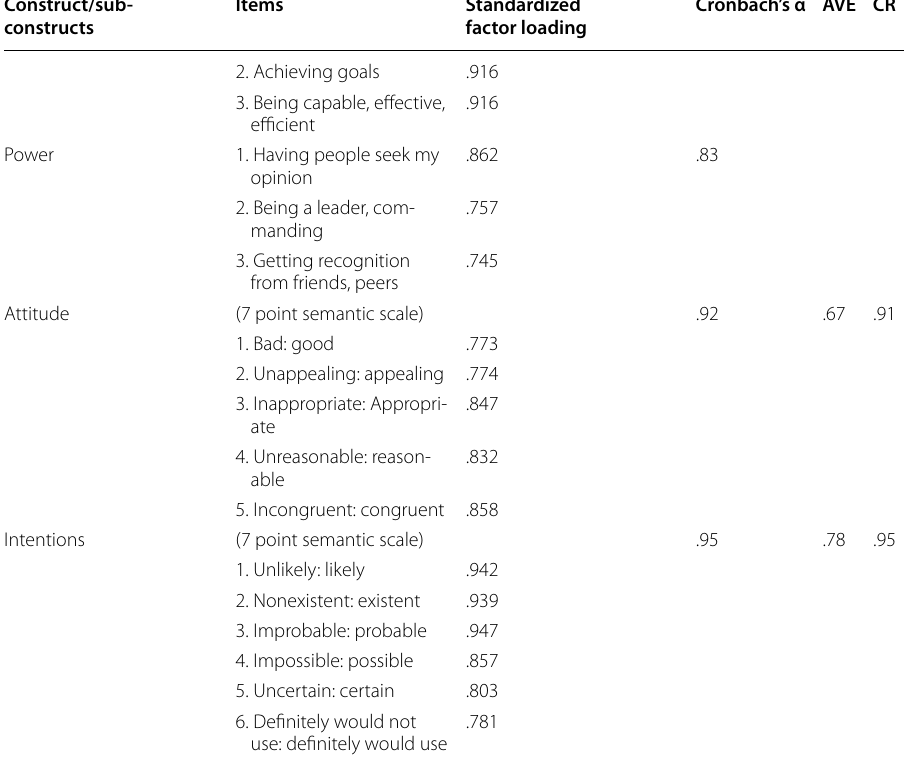
Table 2 Characteristics of the sample ( n